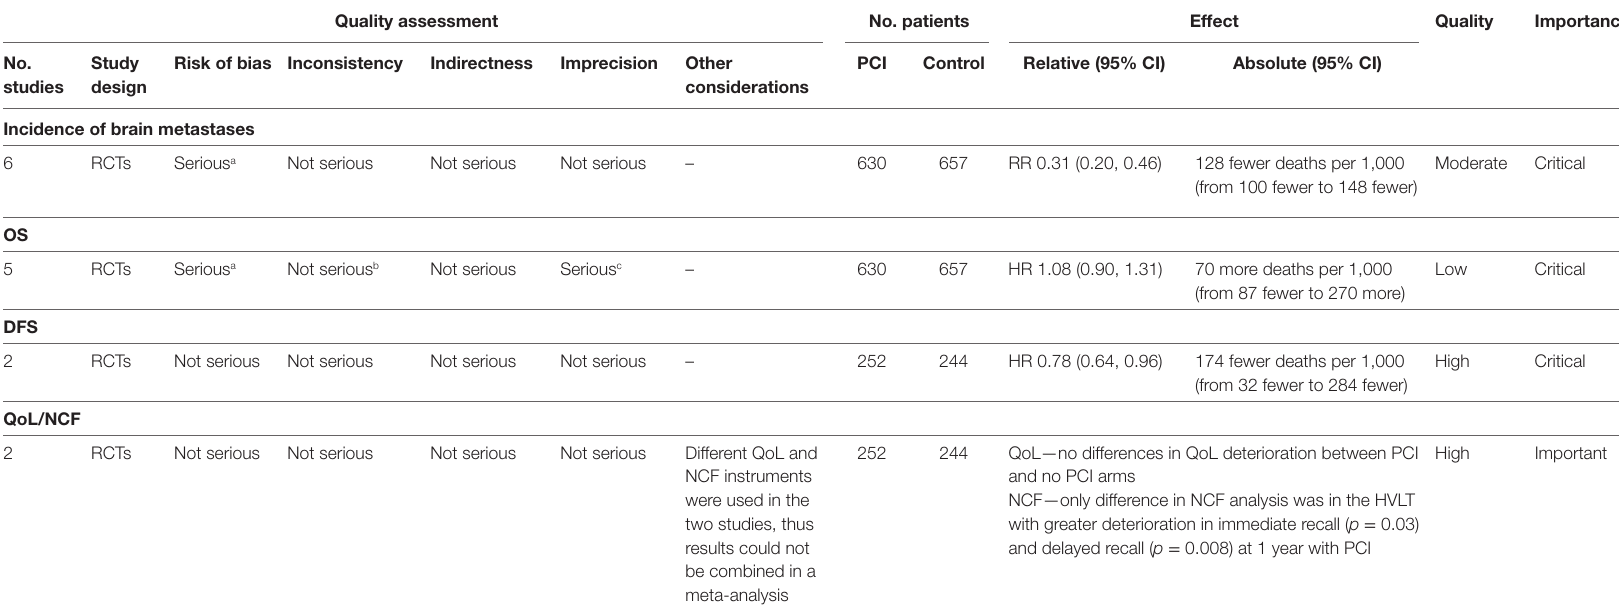
taBLe 4 | Assessment of the quality of the evidence for each outcome using GRADE. Quality